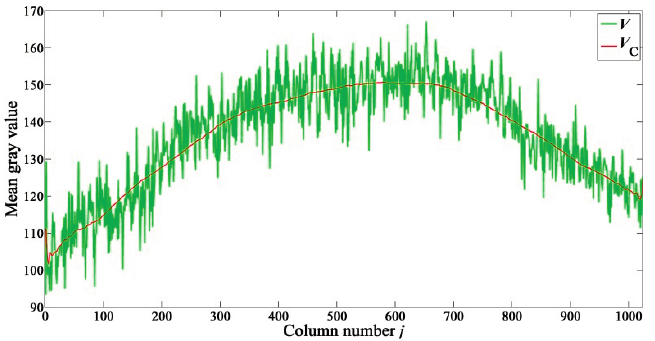
Figure 9. Curves of column-mean vectors V (shown by the green line) and the red